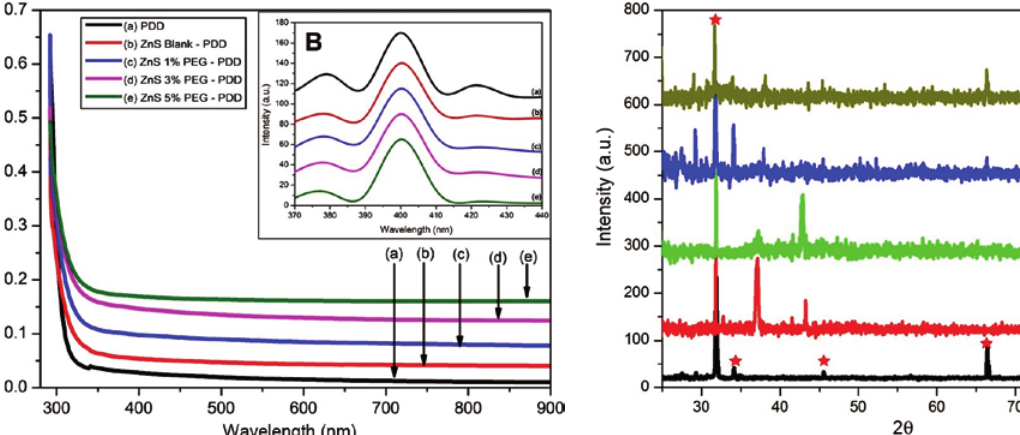
Figure 8: X-ray diffraction patterns of the PDD (a), PDD incorporated with the blank (b) ZnS nanoparticles capped with (c) 1%, (d) 3%, and (e) 5%